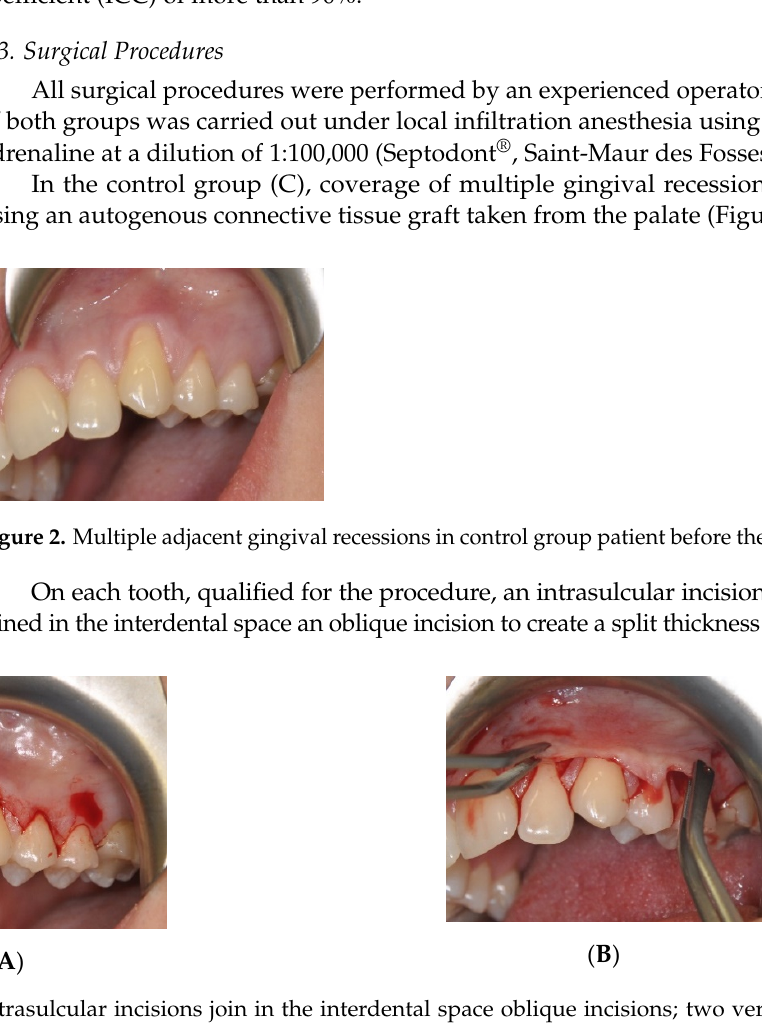
( C ) Figure 7. CTG collection: ( A ) Collection of CTG from the palatal masticatory mucosa, ( B ) Primary wound closure with mattress suturing, ( C ) Demonstration of harvested CTG of adequate size.